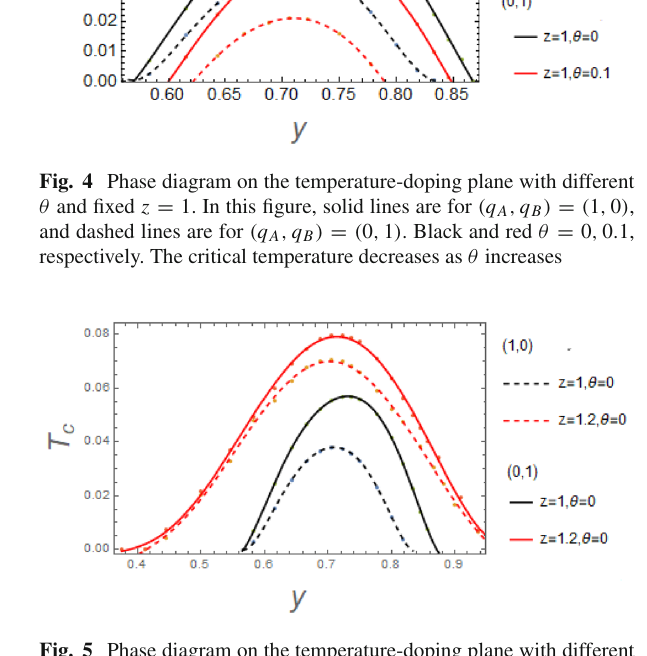
Fig. 5 Phase diagram on the temperature-doping plane with different z and fixed θ = 0. In this figure, solid lines are for ( q A , q B ) = ( 1 , 0 ) , and dashed lines are for ( q A , q B ) = ( 0 , 1 ) . Black and red represent z = 1 , 1 . 2, respectively. The critical temperature increases as θ